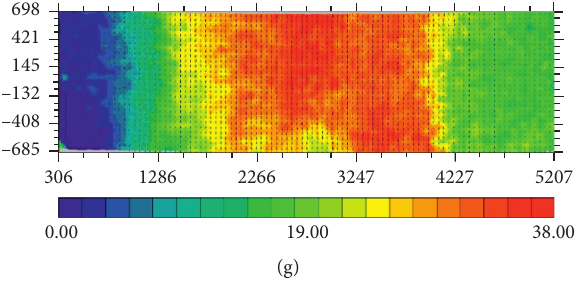
Figure 7: The process of mining and filling and the change of rock strata displacement in model II: (a) mining length 8m, (b) mining length 20m, (c) mining length 32m, (d) mining length 40m, (e) mining length 49m, (f) mining length 57m, and (g) mining length 65m.